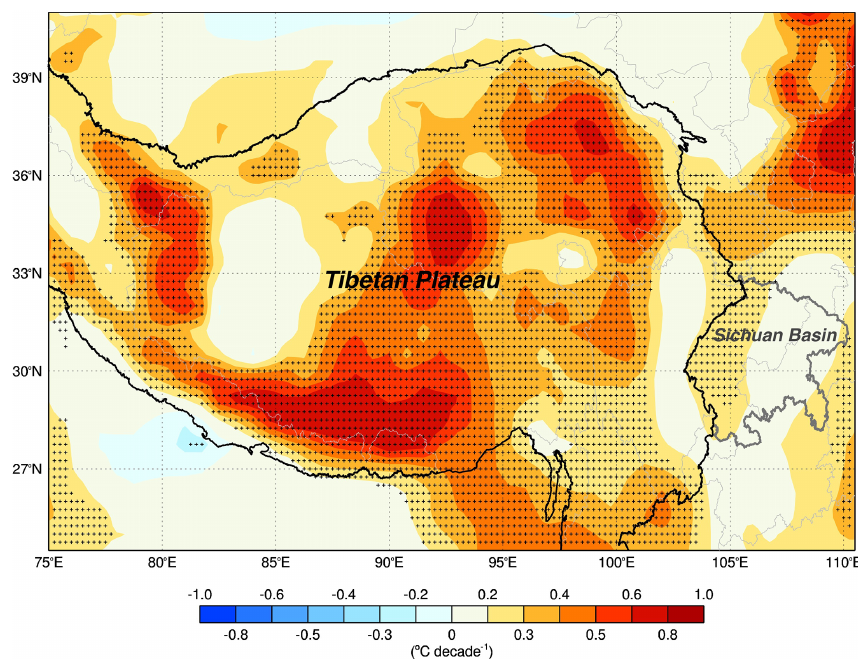
Figure 3. Trends of ERA-Interim reanalysis winter mean temperature over the Tibetan Plateau from 1979 to 2017. The dotted regions show statistical significance with 95% confidence level ( p value < 0.05) from the Student t